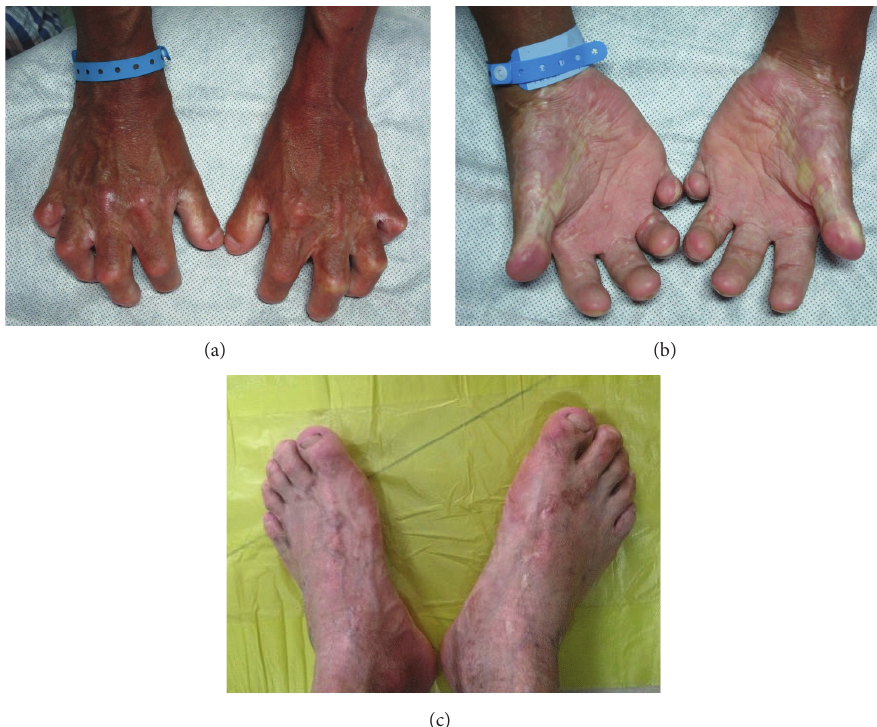
Figure 1: Hands and feet images. (a) Opisthenar; (b) palm; (c) feet. Clinical examination reveals fingers, especially the first and second phalange, were shorter and cannot full straighten. His palms and soles were hyperkeratosis. Fingernails and toenails were dystrophy.